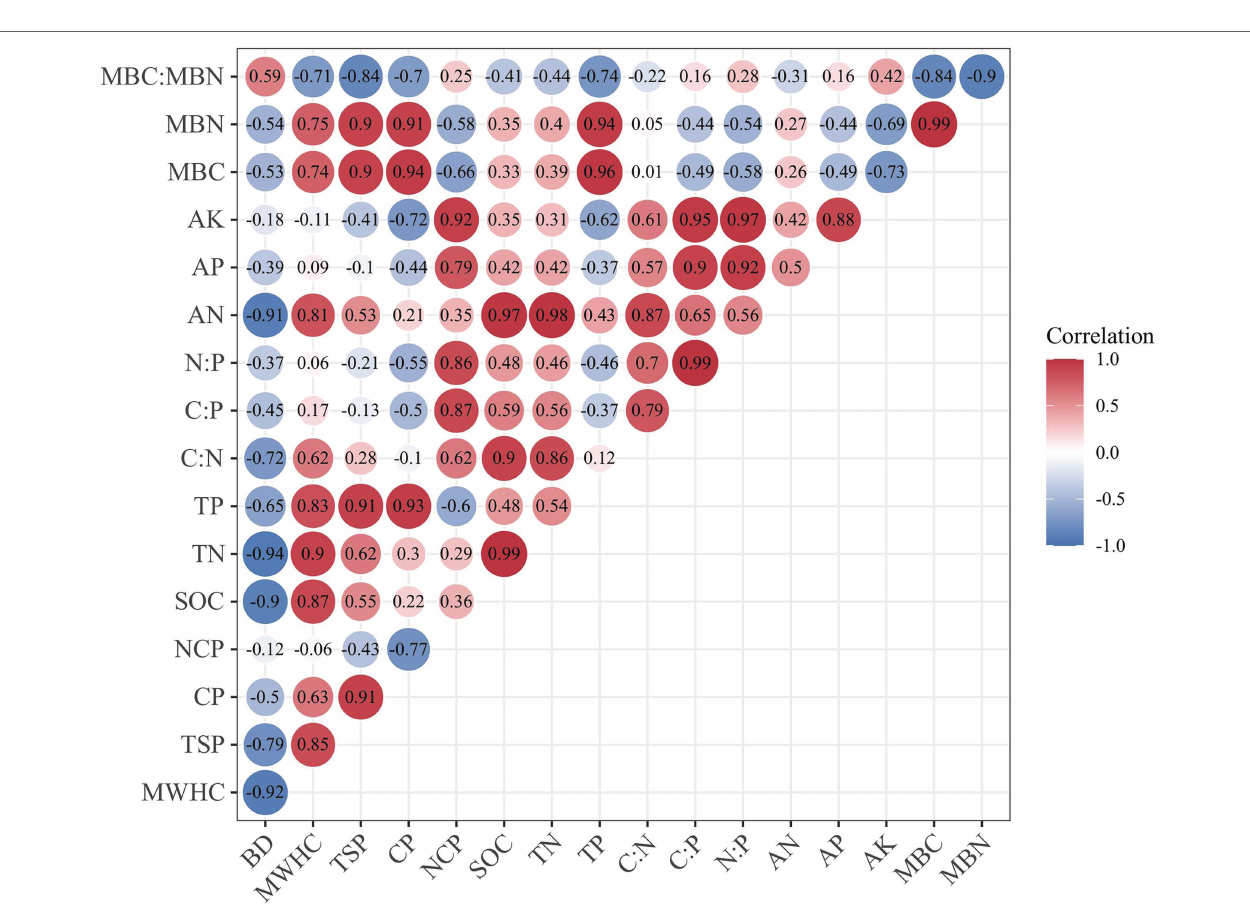
FIGURE 6 | Pearson’s correlation coefficients among soil properties. BD, bulk density; MWHC, maximum soil water holding capacity; TSP, total soil porosity; CP, capillary porosity; NCP, non-capillary porosity; SOC, soil organic carbon; TN, soil total nitrogen; TP, soil total phosphorus; AN, alkali-hydrolyzable nitrogen; AP, available phosphorous; AK, available potassium; MBC, soil microbial biomass C; MBN, soil microbial biomass